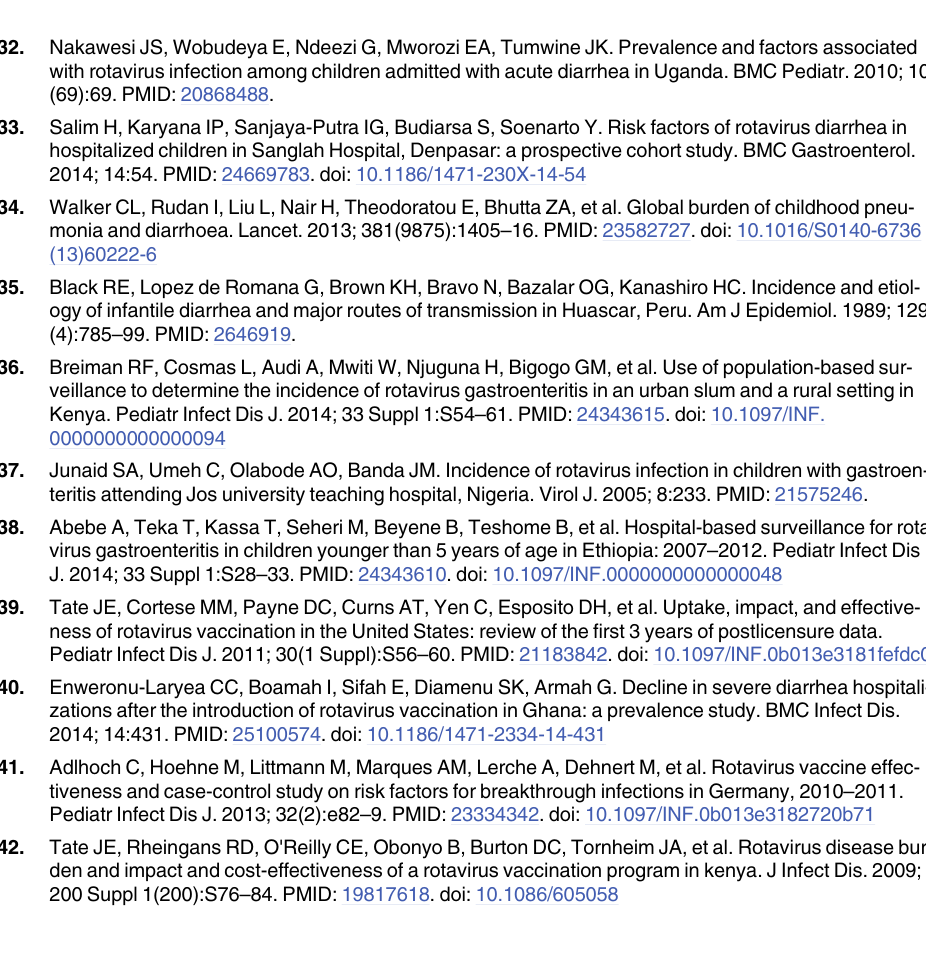
PLOS ONE | DOI:10.1371/journal.pone.0160060 August 5,